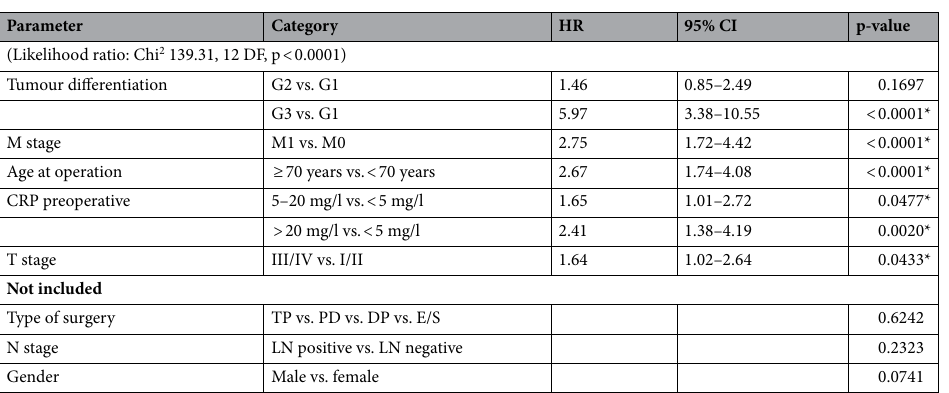
Table 4. Multivariable Cox regression analysis of parameters associated with overall survival in n = 437 pancreatic neuroendocrine neoplasms after surgical treatment (n = 80 patients with missing values were excluded). HR hazard ratio, CI confidence interval, CRP C-reactive protein, PD pancreatoduodenectomy, DP distal pancreatectomy, TP total pancreatectomy, LN lymph node, E/S enucleation/segmental resection. *Statistically